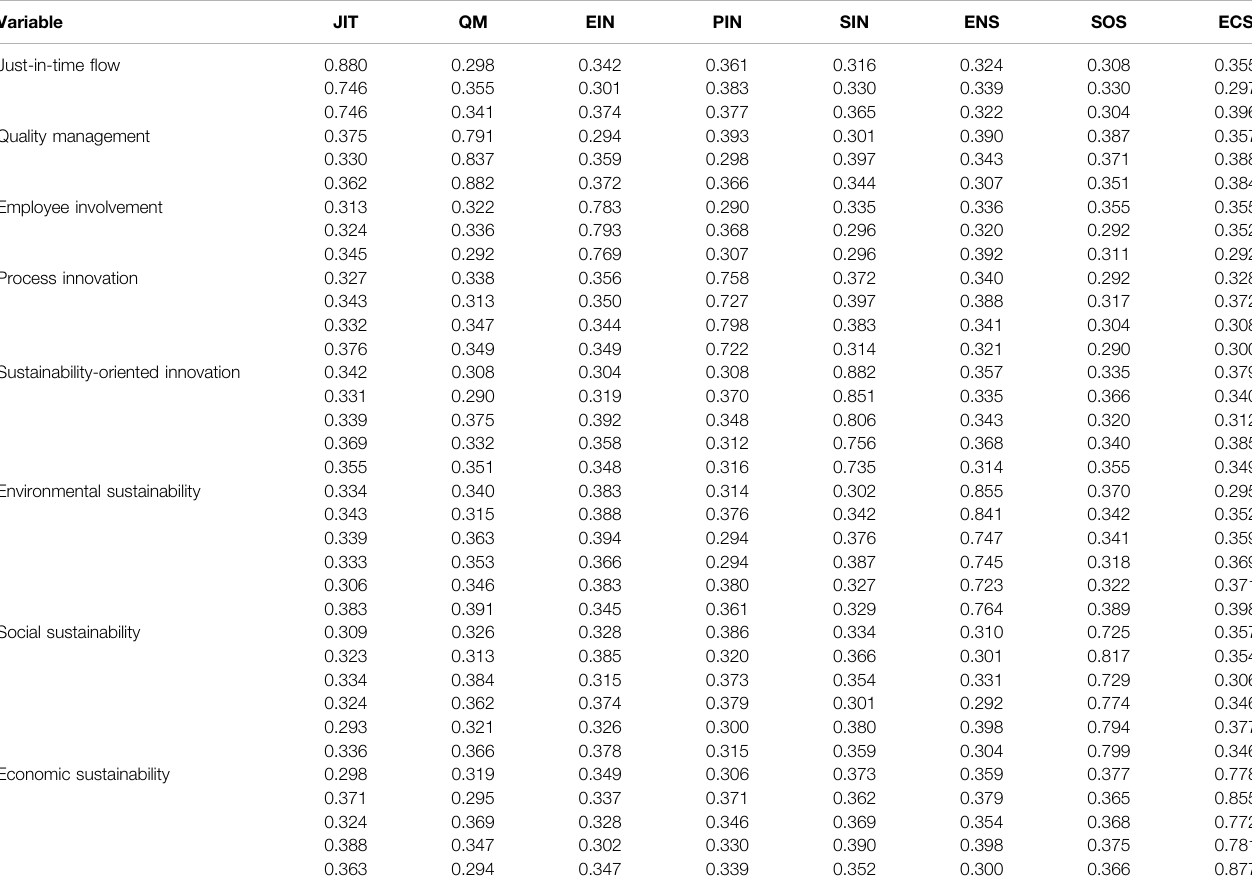
TABLE 4 | Results of loadings and cross loadings.